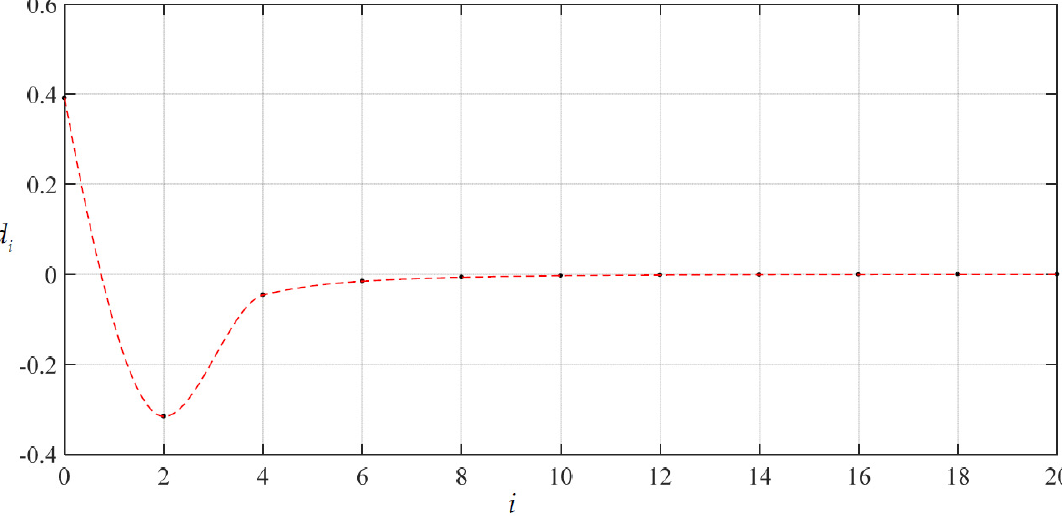
Figure 6. Variation of d i with i when c 0 = 1.98216876 × 10 − 1 , d 0 = 3.91482802 × 10 − 1 and H = 300